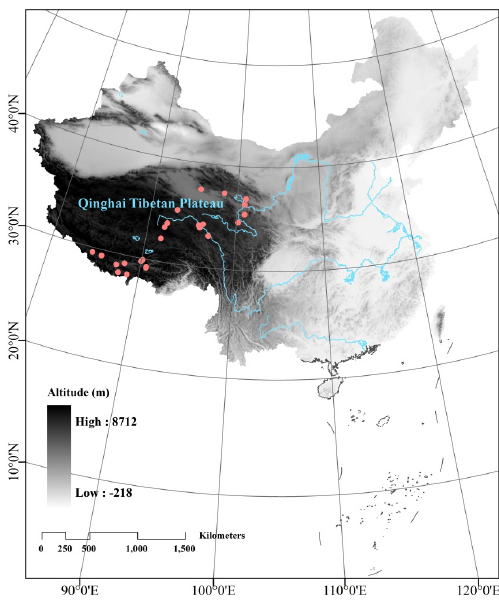
Figure 2. Locations of soil sampling sites ( n = 30) in the QTP (pink solid